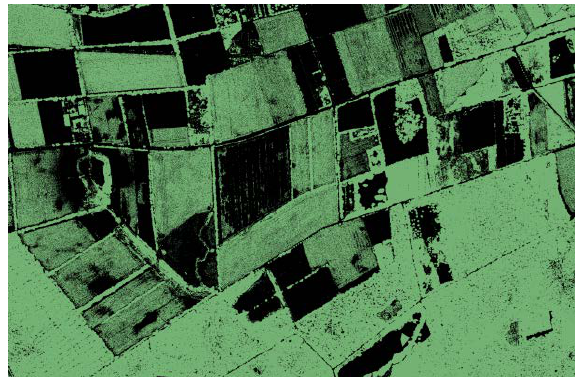
Figure 12. Vegetation reference map solely obtained through LIDAR data. All green pixels represent vegetation higher than